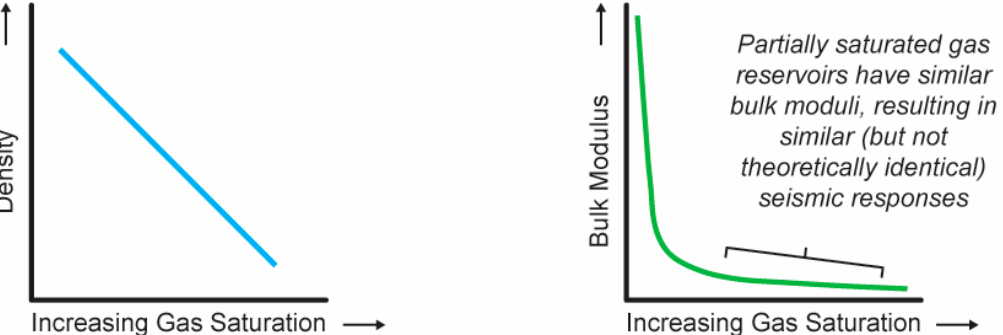
Figure 1. Change in rock properties with increasing gas saturation. The bulk modulus quickly decreases with a relatively small amount of gas saturation. This bulk modulus similarity between low- and high-gas saturation is the crux of the LSG gas differentiation problem.